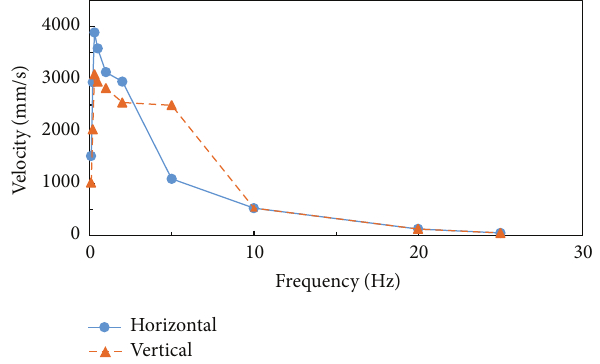
Figure 11: Design response spectrum considering a 2% damping ratio in the horizontal and vertical directions, as stipulated in the KEPIC MFA.